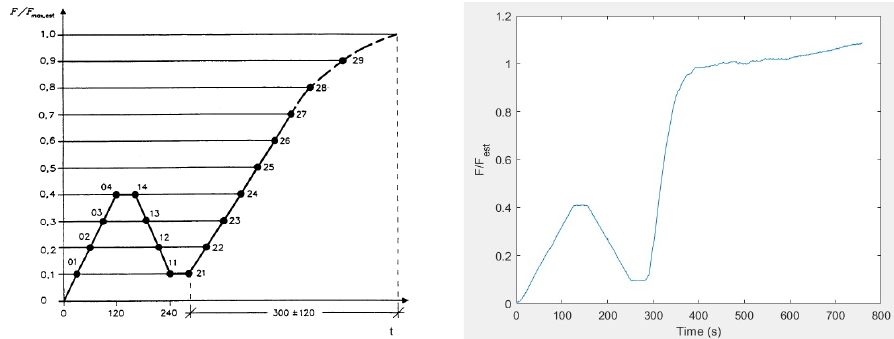
Figure 4. Loading procedure provided by EN 383 ( left ) and experimental loading procedure ( right ). The embedment strength was determined according to Equation (1), and charac- 𝑓𝑓 ℎ